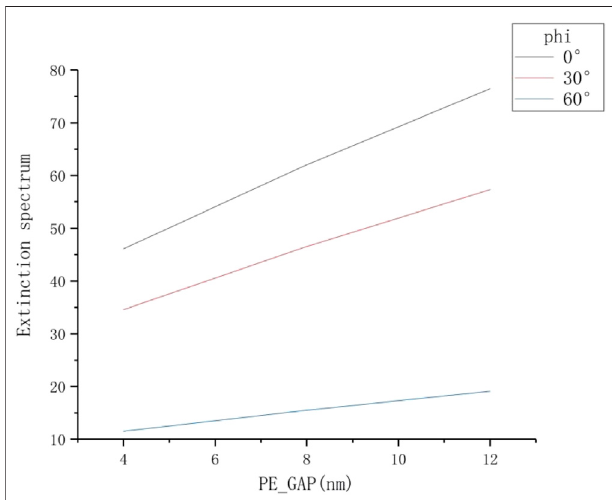
FIGURE4| TheextinctionspectrumwithdifferentthicknessofPEunder different azimuth angle conditions.